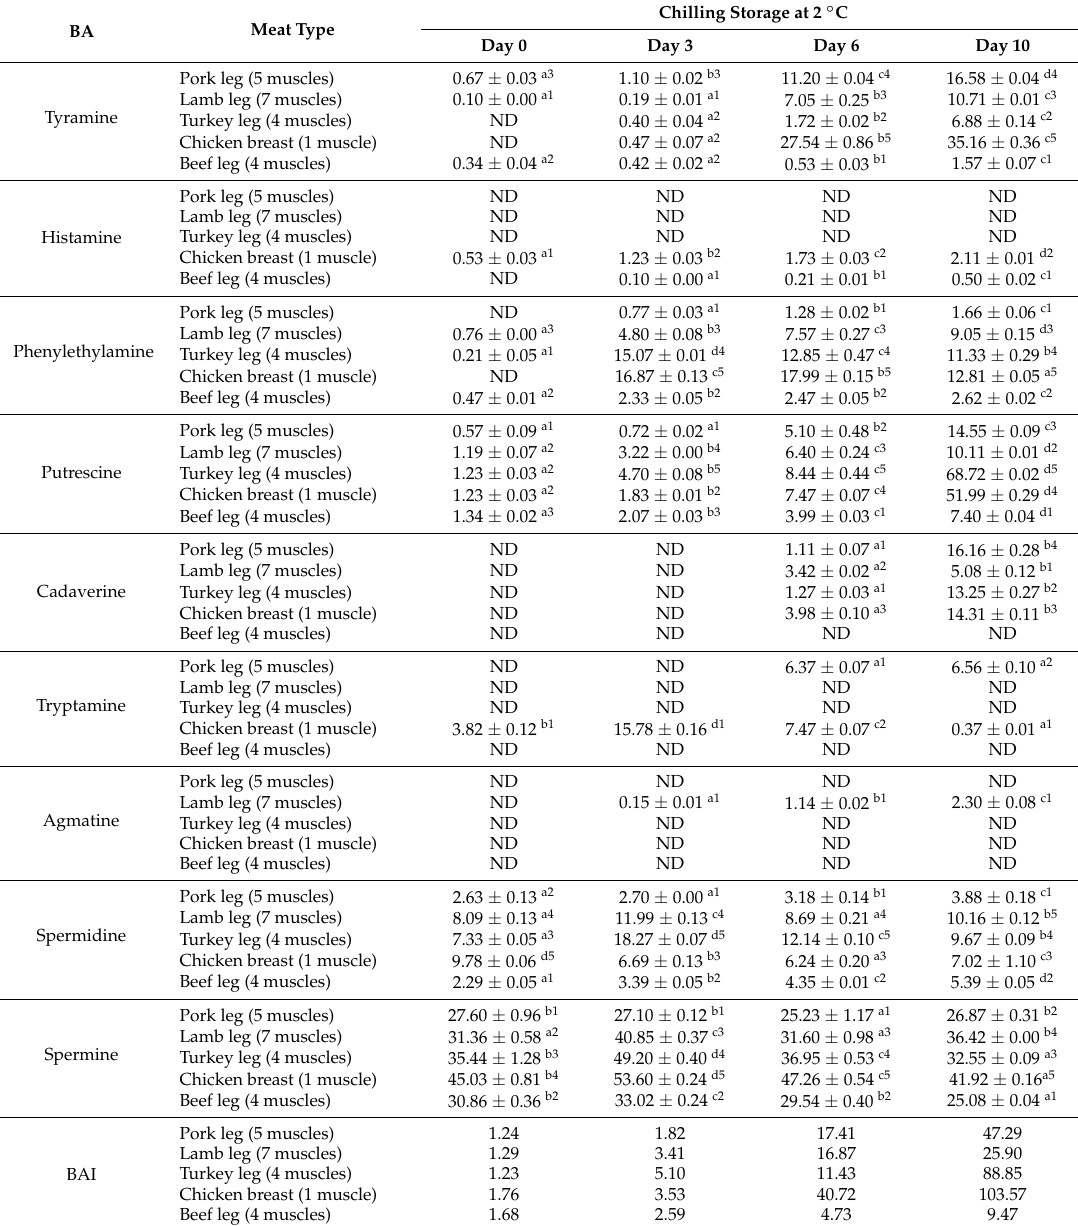
Table 4. Biogenic amines (BA) concentration (mg/kg) of fresh different meat types during chilled storage at 2 ◦